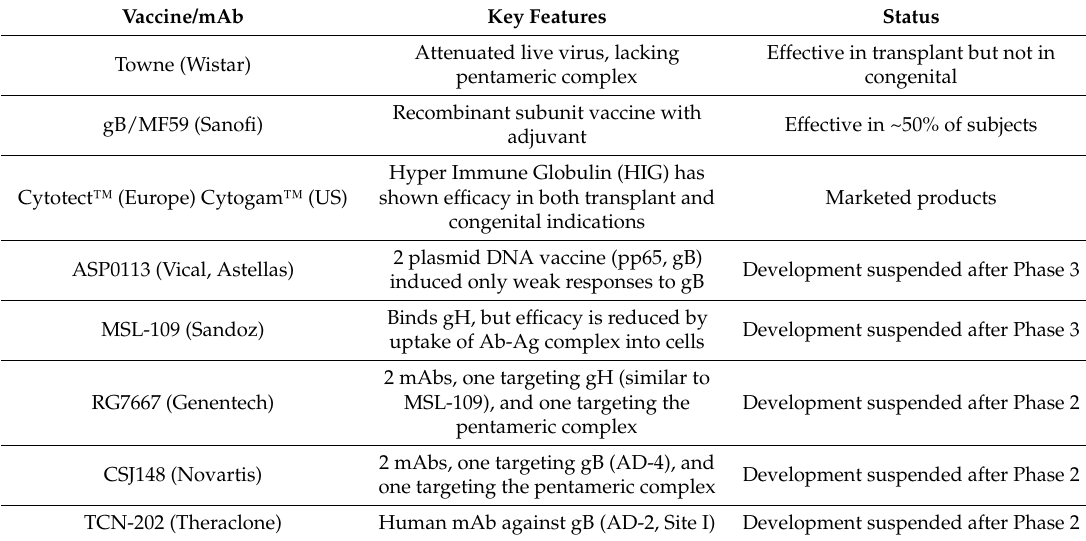
Table 1. Status of HCMV vaccines and antibody-based therapeutics with clinical data.